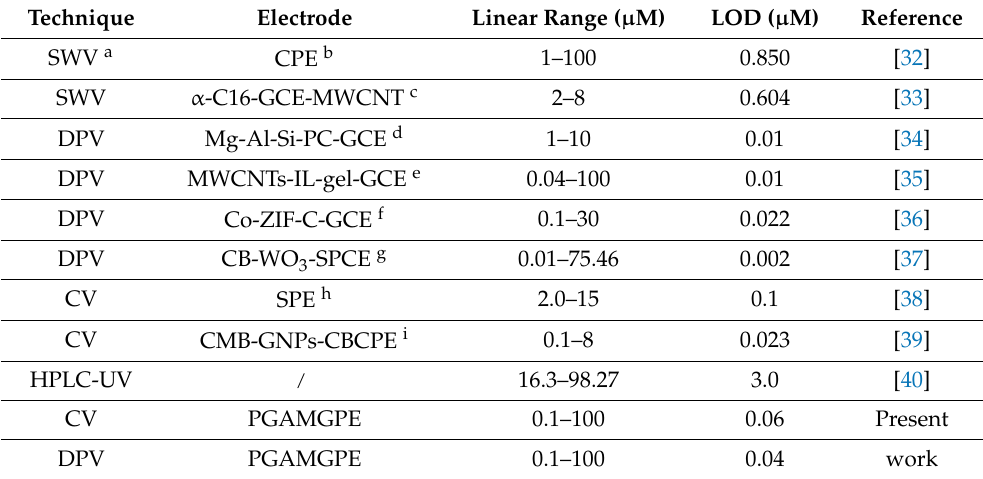
Table 1. Comparison of the present RU LOD at PGAMGPE with the previous RU